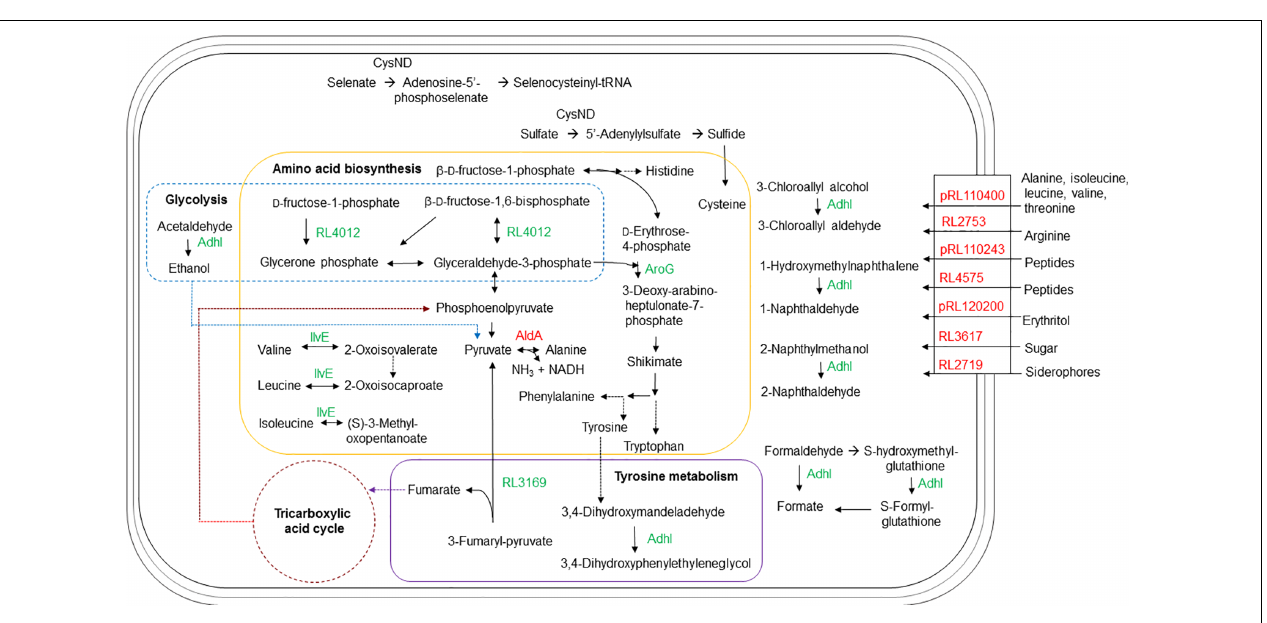
FIGURE 4 | Schematic representation of the metabolic pathways and transport in R. leguminosarum bv. viciae affected by the ctpA mutation. In green are proteins with more abundance in the ctpA mutant and in red proteins have lesser abundance in the ctpA mutant. Solid arrows indicate a single step, while dashed arrows indicate multiple